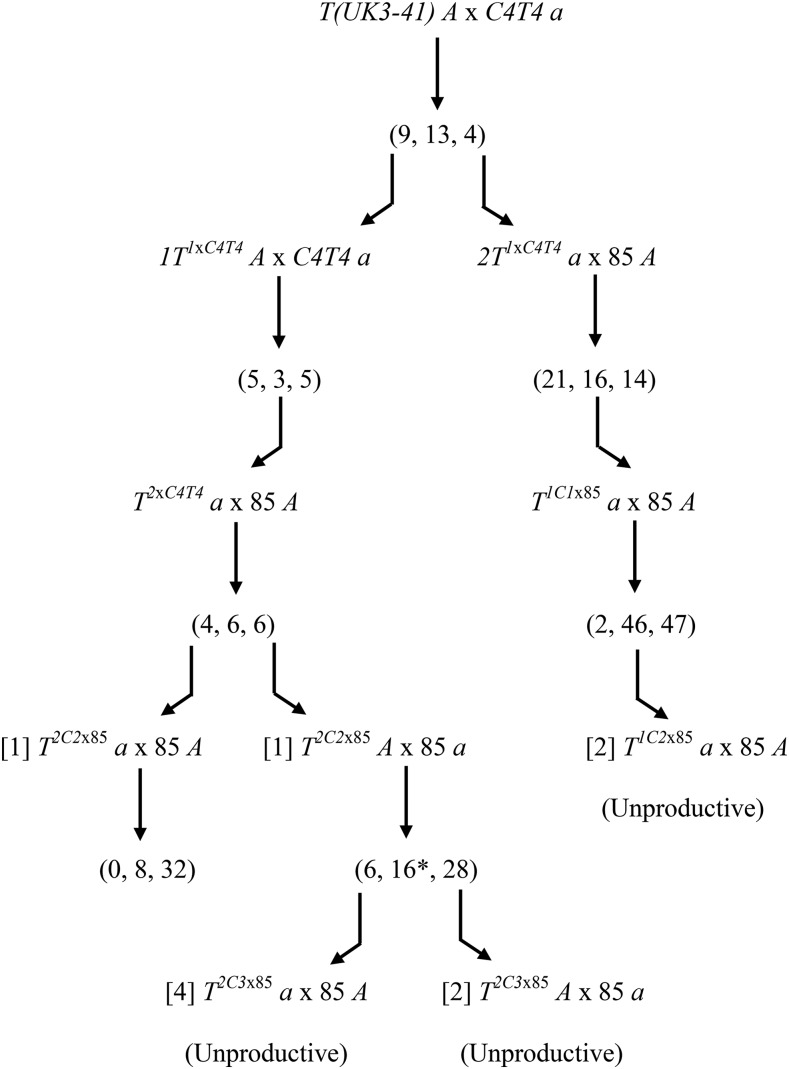
Attempt to introgress T(UK3-41) into N. tetrasperma. N. crassa strain T(UK3-41) A was crossed with the C4T4 a hybrid strain. PCR with breakpoint junction-specific primers was done to identify the progeny types, and the number of translocation, normal sequence, and duplication types is indicated in the sequence (T, N, Dp). Bent arrows represent the T progeny used for the next round of crosses (e.g., 1T1xC4T4A, 2T1xC4T4 a). 1T1xC4T4A × C4T4 a yielded the strain T2xC4T4 a, which was productive in crosses with N. tetrasperma strain 85 A. Of the 4 T2C2x85 progeny, two were unproductive in crosses, one (T2C2x85
a) was productive in the cross with 85 A, and its cross produced 0 T progeny; its sibling strain 2T1xC4T4 a was productive in the cross with 85 A, producing six T progeny strains (4 T2C3x85
a and 2 T2C3x85
A) that gave unproductive crosses with 85 A or 85 a. One of the 16 N type progeny (asterisk) from T2C2x85
A × 85 a was a self-fertile [mat A + mat a] heterokaryon. The crosses of two T1C2x85
a strains with 85 A also were unproductive. PCR, polymerase chain reaction.